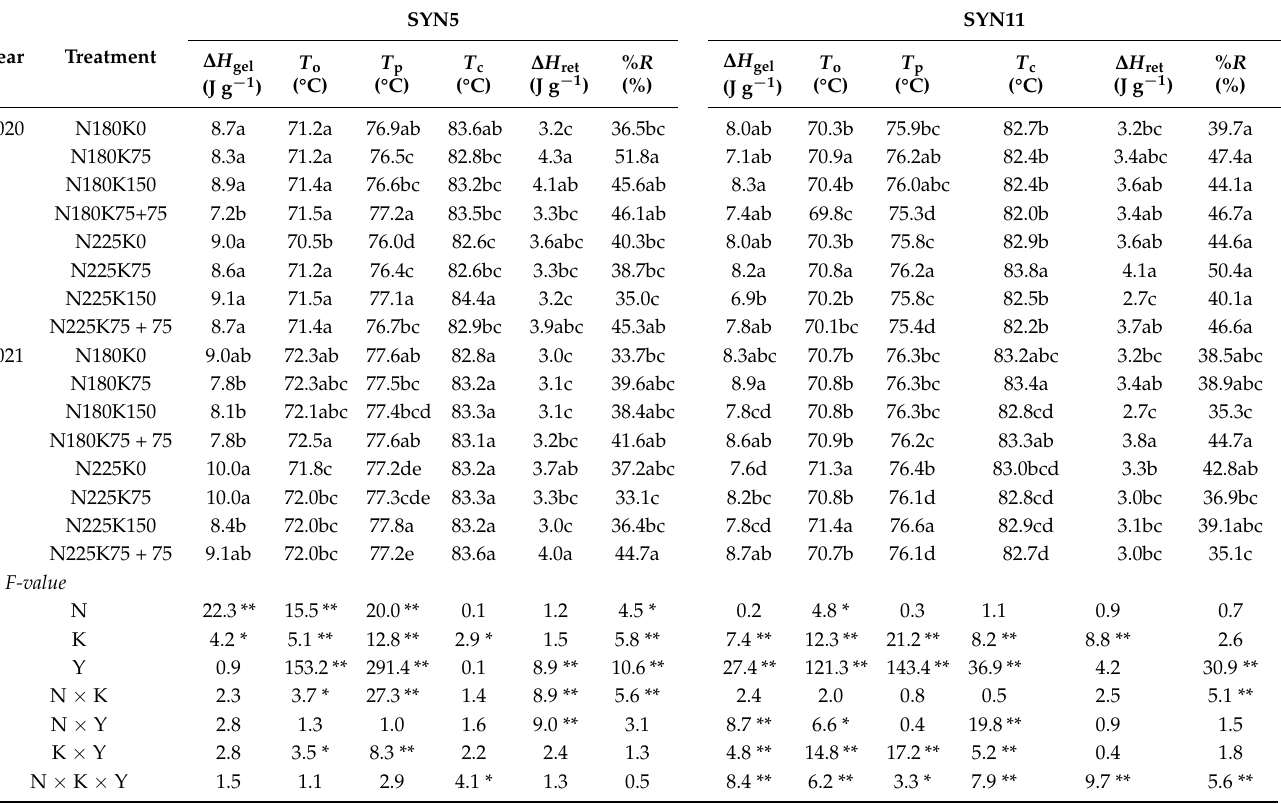
Table 3. Interactive effects of nitrogen and potassium on thermal properties of waxy